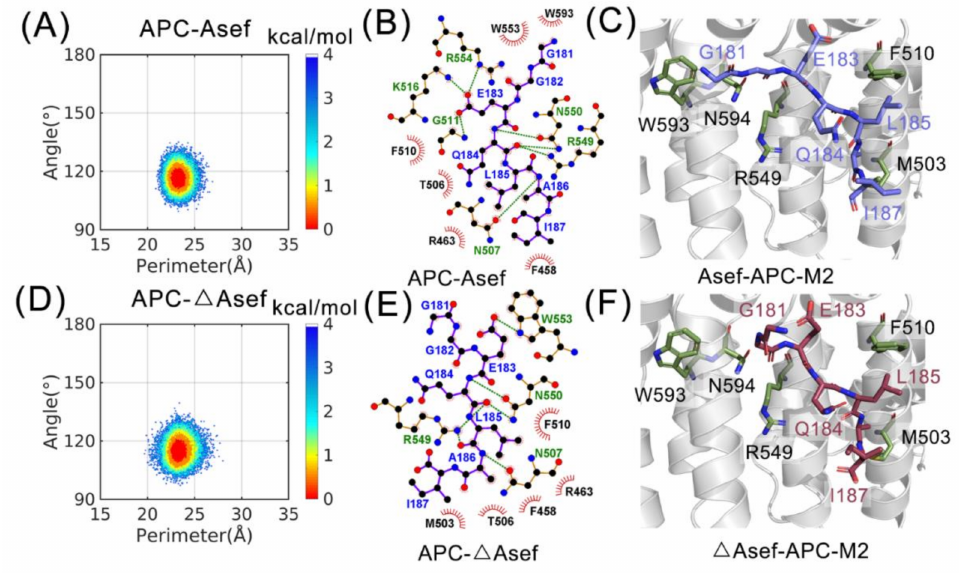
Figure 3. Free-energy landscapes of APC-Asef ( A ), and APC- ∆ Asef ( D ) systems with corresponding interactions between APC and interface heptapeptide in ( B , E ). Green-dashed lines represent hydrogen bonds, while red arcs show the hydrophobic contacts. Structural superimposition of APC-Asef to APC-M2 ( C ), and APC- ∆ Asef to APC-M2 ( F ). Holo APCs are neglected for clarity in ( C , F